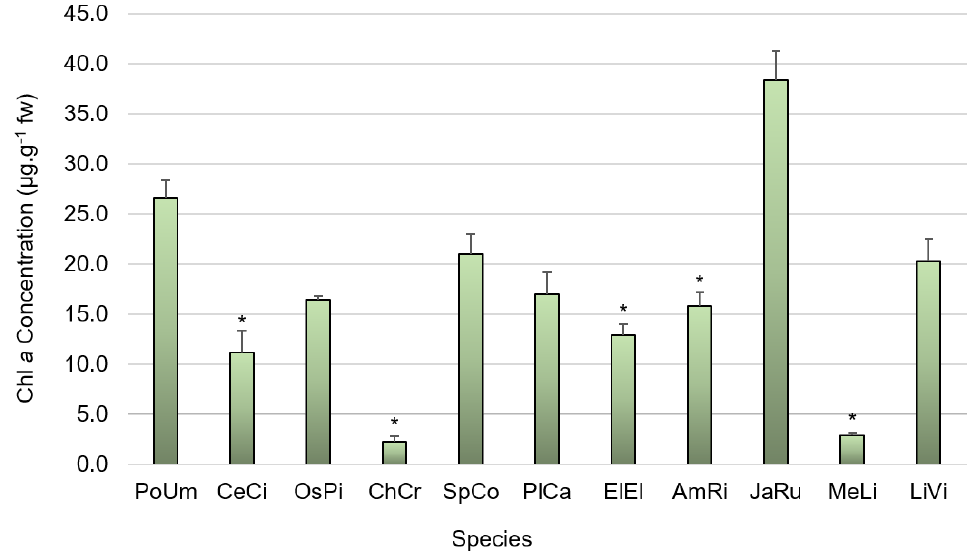
Figure 7. Carotenoid concentration of the eleven studied red seaweed species expressed in µg.g −1 fresh weight. PoUm: Porphyra umbilicalis , CeCi: Ceramium ciliatum , OsPi: Osmundea pinnatifida , ChCr: Chondrus crispus , SpCo: Sphaerococcus coronopifolius , PlCa: Plocamium cartilagineum , ElEl: Elisolandia elongata , AmRi: Amphiroa rigida , JaRu: Jania rubens , MeLi: Mesophyllum lichenoides , LiVi: Liagora viscida . Values are presented as means ± SD ( n = 3), and asterisks (*) indicate statistically significant differences between the species with the highest carotenoid content (PoUm) and all other remaining species (Kruskal–Wallis test ( χ 2 (10) = 31.451; p = 0.000)).